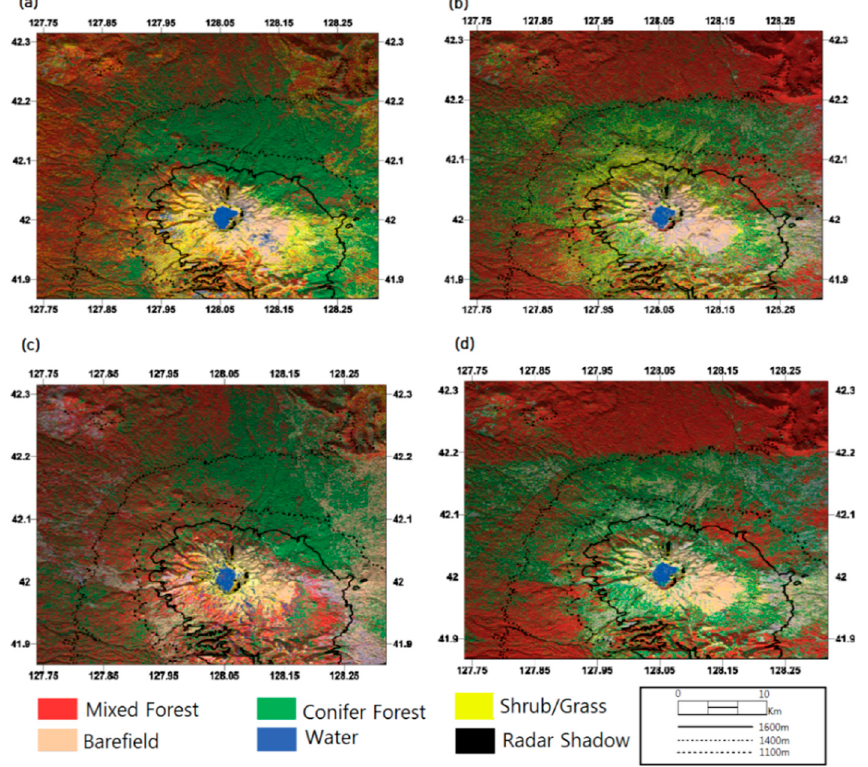
Figure 2. The land cover classifications with PCA/ML over Mt. Baekdu from ( a ) HH1 packet during 2009/07–2010/03; ( b ) HH2 packet during 2010/03–2010/10; ( c ) HH3 packet during 2010/10–2011/03; and ( d ) HH-HV packet during 2010/06–2010/10.